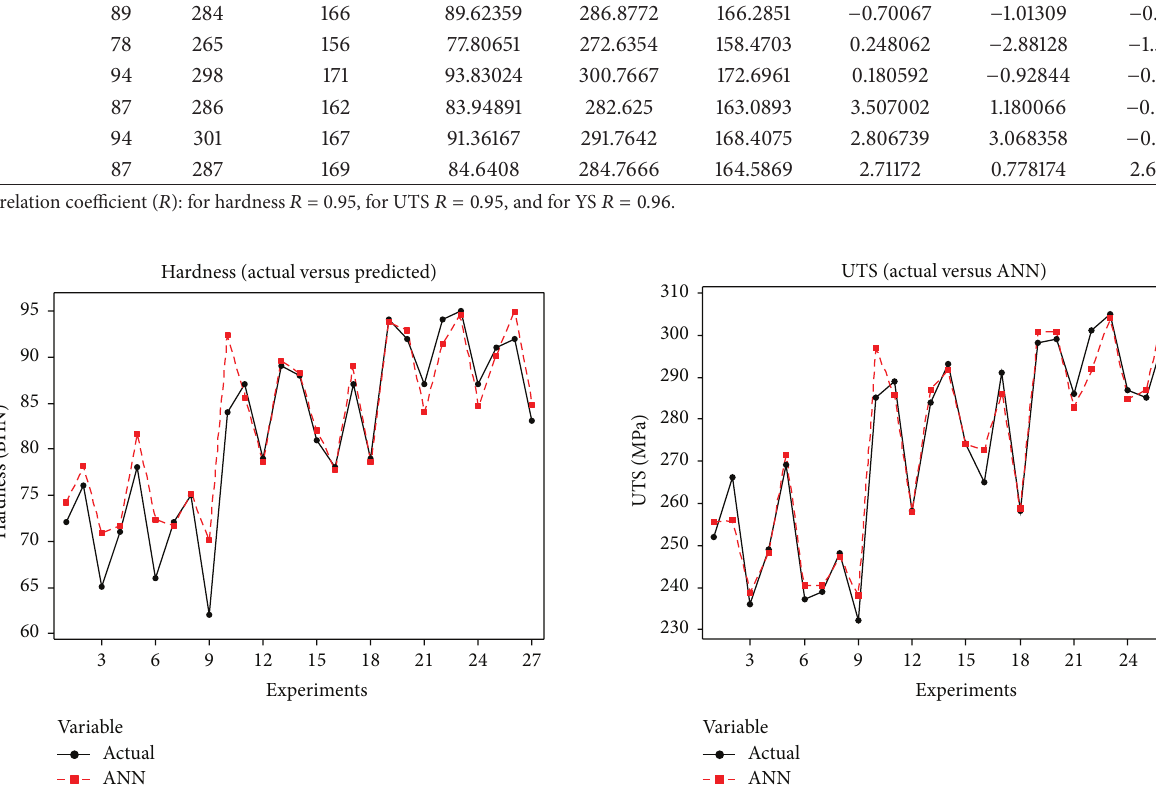
Figure 6: Actual versus ANN predicted results for hardness. Figure 7: Actual versus ANN predicted results for